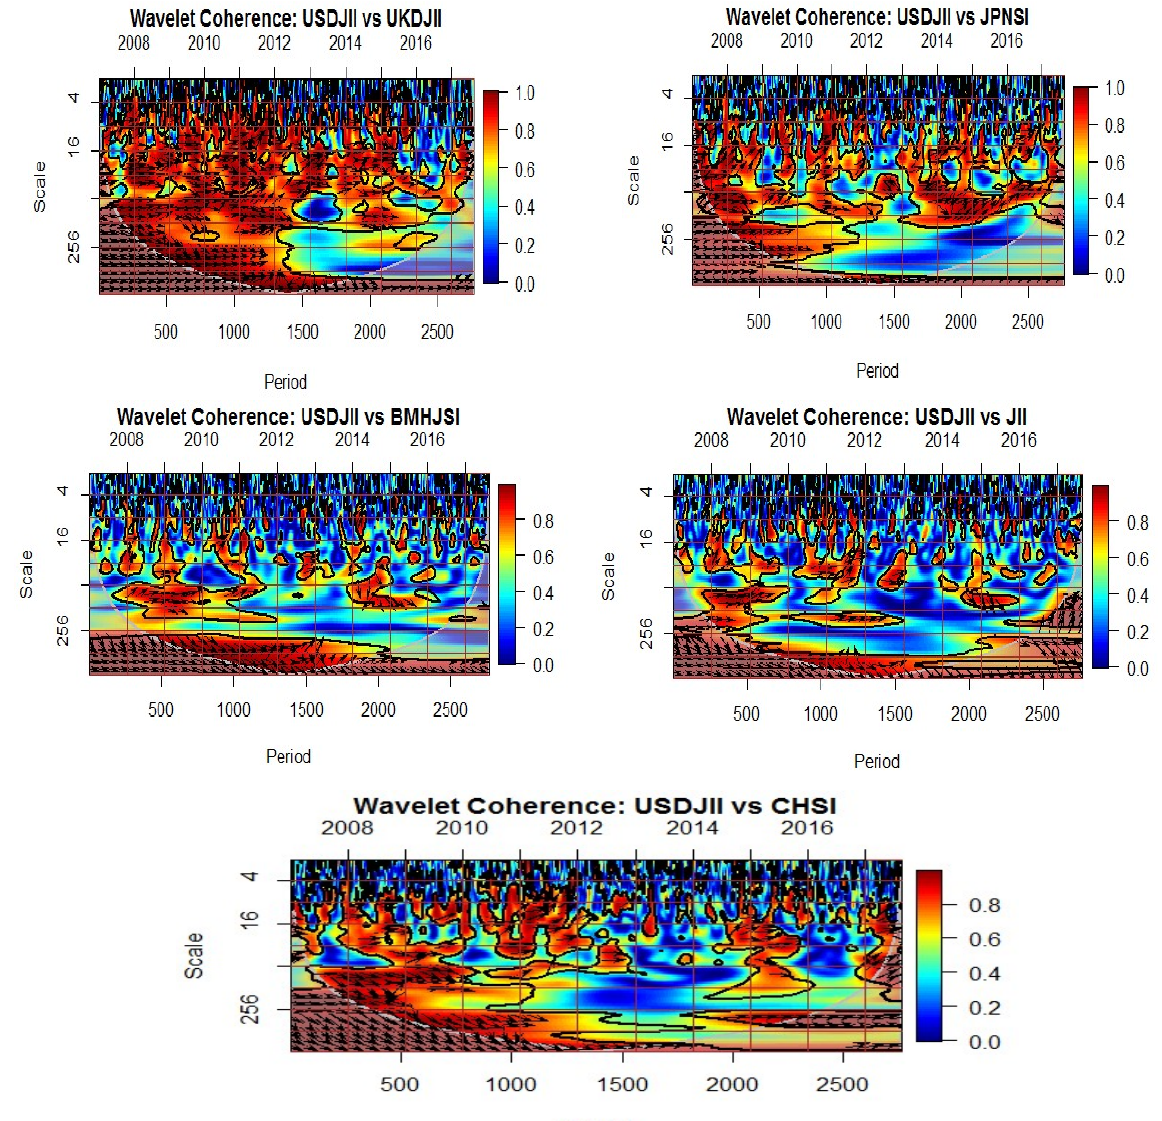
Figure 3. WCT: USDJII vs. UKDJII; USDJII vs. JPNSI; USDJII vs. BMHJSI; USDJII vs. JII; USDJII vs. CHSI.